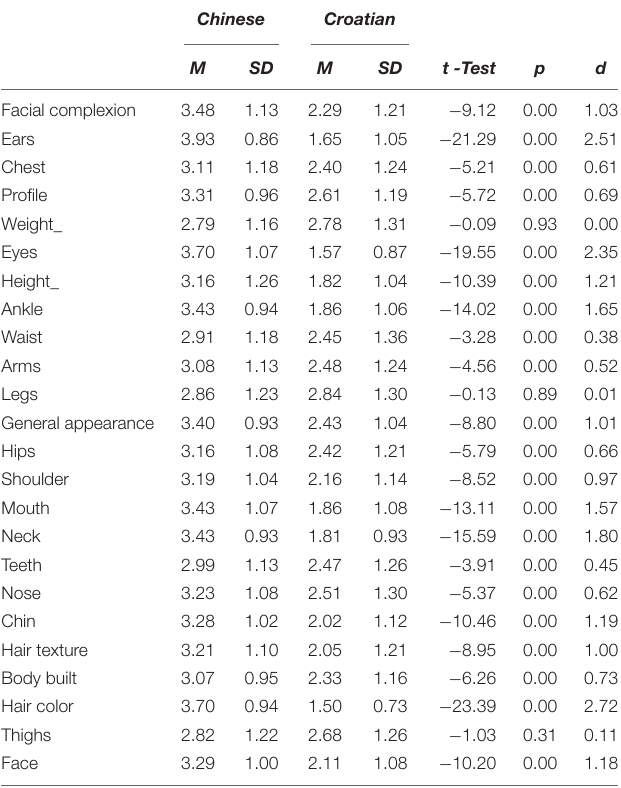
TABLE 5 | Independent Samples t -tests between BAS items in two cultural groups. Chinese Croatian